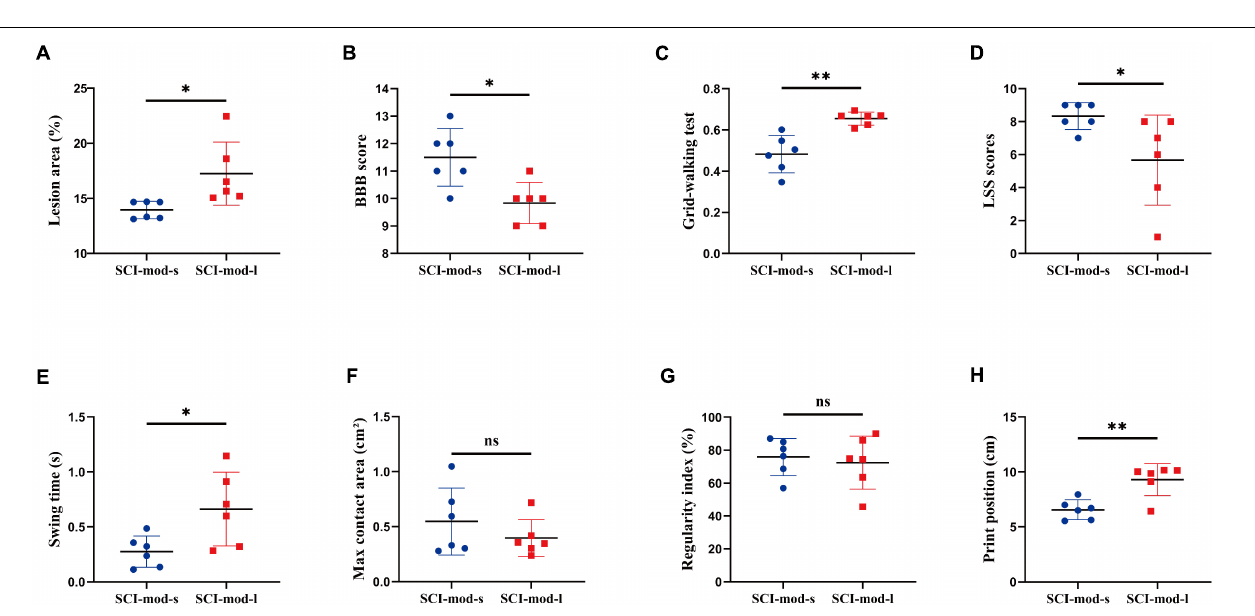
FIGURE 6 | Comparison between the SCI-mod-s group and SCI-mod-l group on (A) lesion area, (B) BBB score, (C) grid-walking test, (D) LSS scores, (E) swing time, (F) max contact area, (G) regularity index, (H) print position. n = 6 per group ( ∗ p < 0.05; ∗∗ p < 0.01; ns represents no statistical